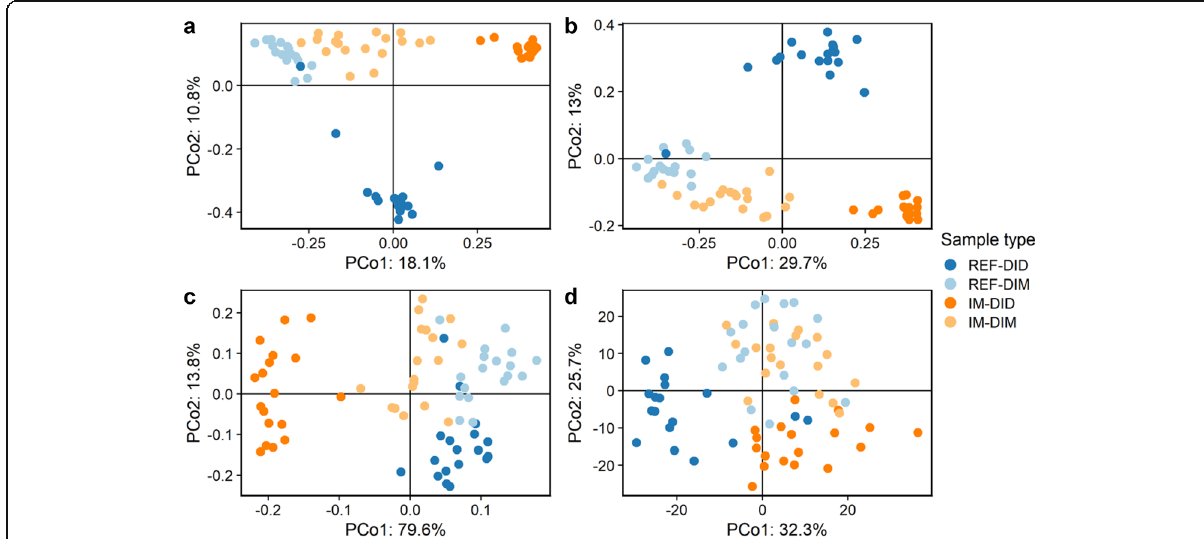
Fig. 4 The sample origin and diet effects on the beta-diversity of distal intestinal microbiota in seawater phase Atlantic salmon. The PCoA plots were built on Jaccard ( a ), unweighted UniFrac ( b ), Aitchison ( c ) and phylogenetic isometric log-ratio (PHILR) transformed Euclidean ( d ) distance matrix, respectively. PCo, principle coordinate; REF, reference diet; IM, insect meal diet; DID, distal intestine digesta; DIM, distal intestine